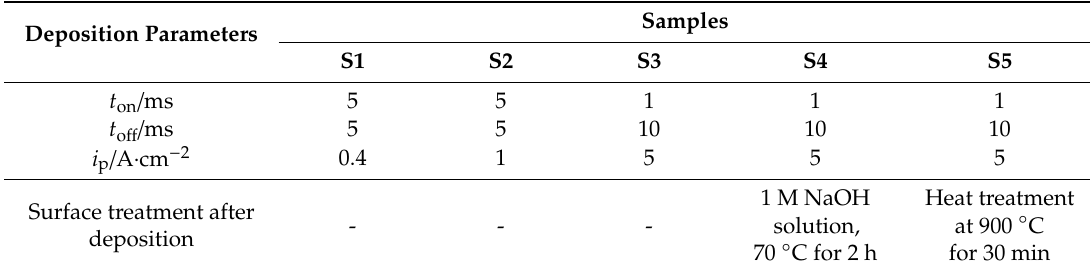
Table 1. Preparation parameters of the electrodeposited CPC coatings.